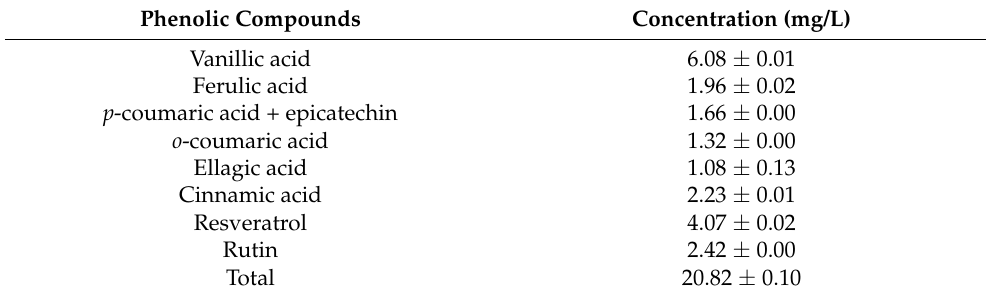
Table 2. Phenolic acids and flavonoids present in the freeze-dried amaranth ( Amarathus cruentus sp.) grain extract. Phenolic Compounds Concentration (mg/L) Vanillic acid 6.08 ± 0.01 Ferulic acid 1.96 ± 0.02 p -coumaric acid + epicatechin 1.66 ± 0.00 o -coumaric acid 1.32 ± 0.00 Ellagic acid 1.08 ± 0.13 Cinnamic acid 2.23 ± 0.01 Resveratrol 4.07 ± 0.02 Rutin 2.42 ± 0.00 Total 20.82 ±